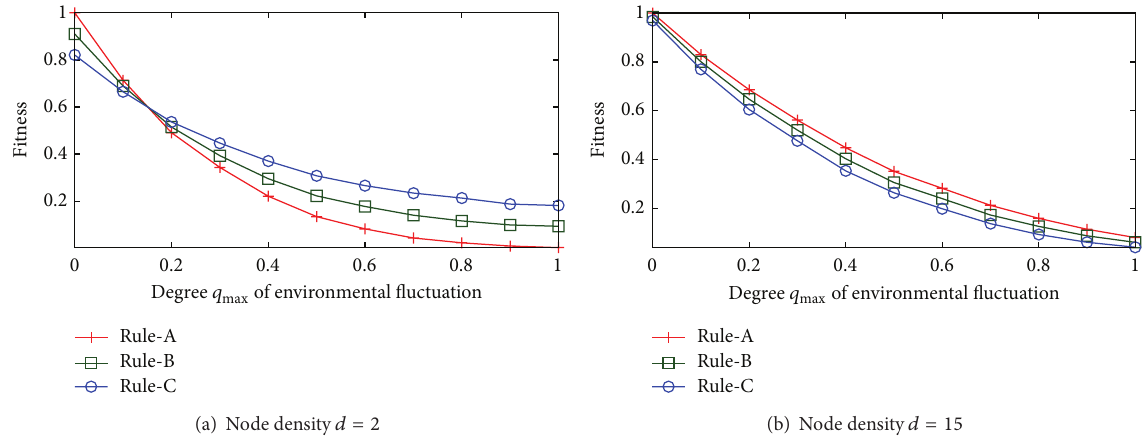
Figure 3: Impact of environmental fluctuation on the average